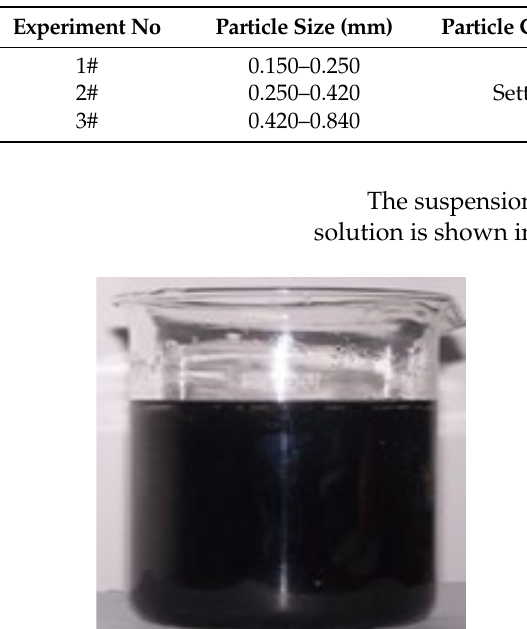
Table 3. Particle Suspension Data at Different Particle Concentrations.